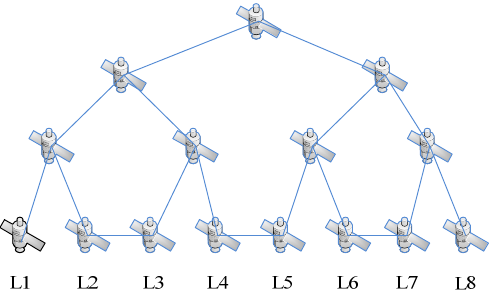
Figure 3. Satellite network ( 1 L – 8 L represents the lowest altitude satellite node) (time T2).